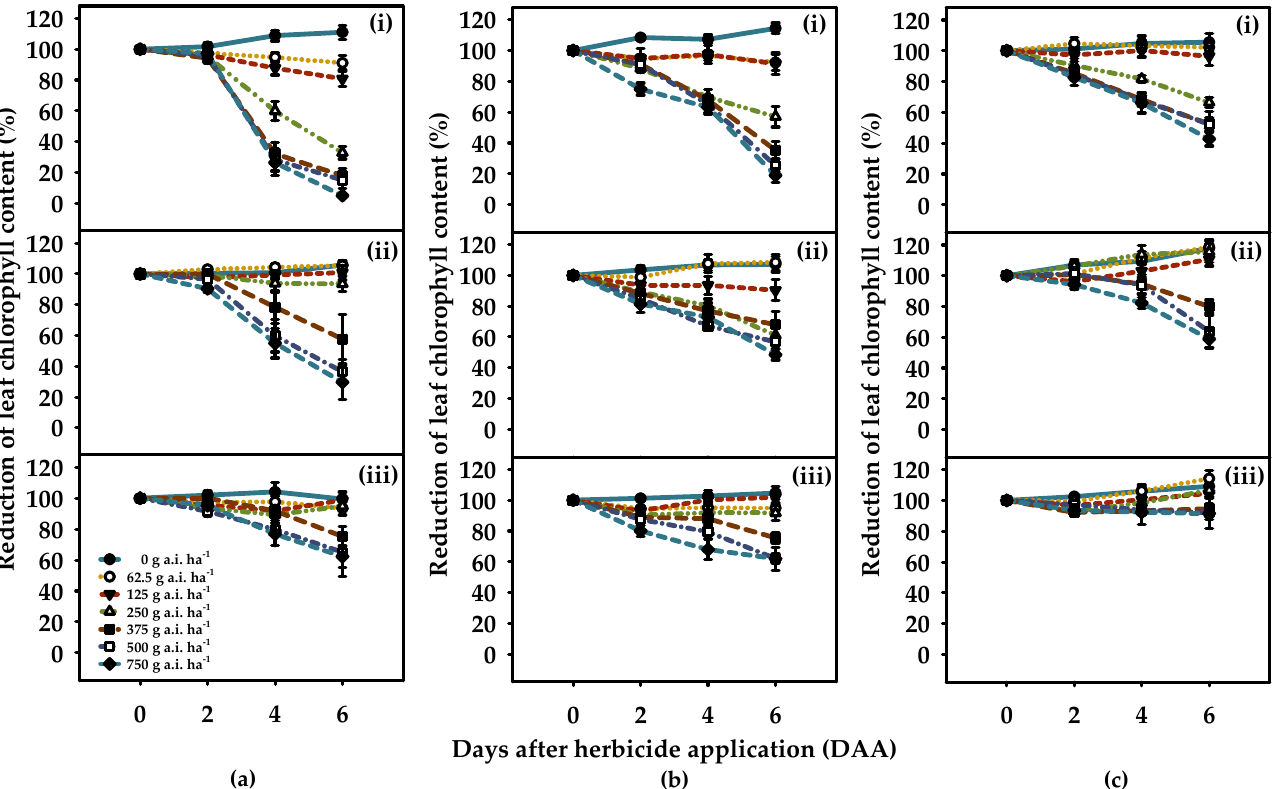
Figure 1. Reduction of leaf chlorophyll content, estimated in SPAD units, of glyphosate-treated C. truncata ( a ), S. oleraceus ( b ), and C. bonariensis ( c ) plants grown under ( i ) high soil moisture availability–HSM (90–100% of the WHC), ( ii ) moderate soil moisture availability–MSM (50–60% of the WHC) and ( iii ) reduced soil moisture availability–RSM (20–30% of the WHC), over the six days after the glyphosate application at various rates. Error bars represent the ± two standard errors of the mean (n = 8) from repeated experiments. The recommended rate for the control of C. truncata, S. oleraceus, and C. bonariensis in the Northern Grain Region’s summer fallow is 740, 705, and 658 g a.i. ha -1 , respectively.